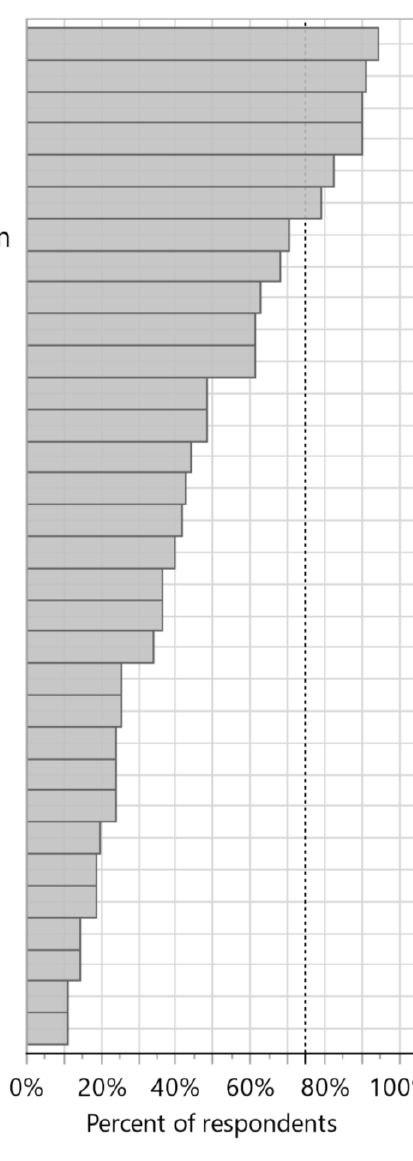
Figure 3. Within- s tand variables for which forest managers would like information from wildlife scientists. Dotted line represents 75% of survey respondents. scientists. Dotted line represents 75% of survey